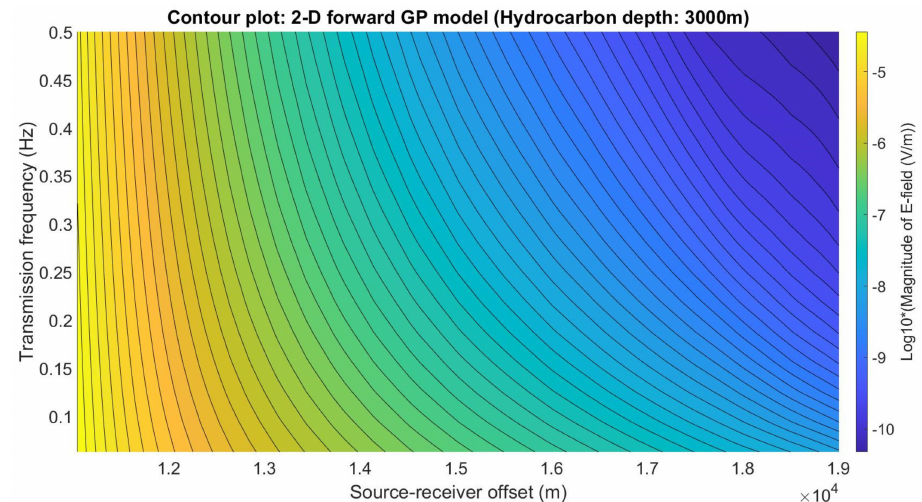
Figure 8. Contour plot of the 2D forward GP model. EM responses versus source-receiver separation distance for all tried and untried transmission frequencies (0.0625–0.5 Hz) at overburden thickness of 3000 m.